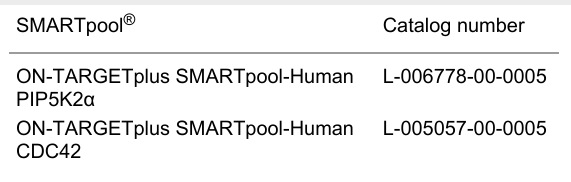
Table 3: siRNA-pools used to transfect HeLa cells (Dharmacon SMARTpool ®